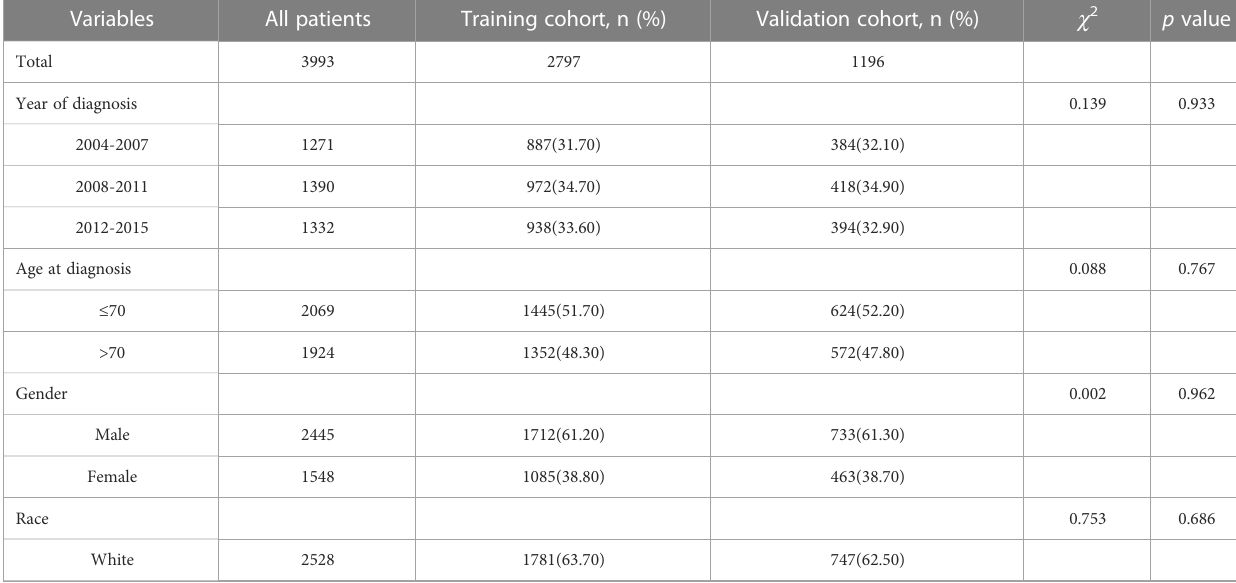
TABLE 1 Demographic and clinicopathologic variables in the training and validation cohort. Variables All patients Training cohort, n (%) Validation cohort, n